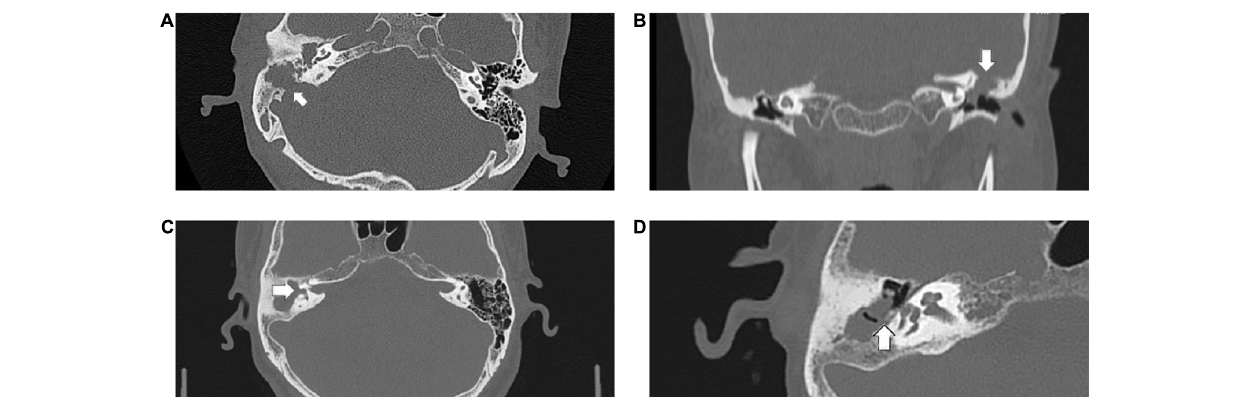
FIGURE 1 | The following CT scan findings were recorded as score 2: (A) the sigmoid sinus bone plate eroded (arrowed), (B) coronal section of the left epitympanum demonstrating a tegmen tympani defect (arrowed), (C) a large defect of the lateral semicircular canal (arrowed), (D) the pyramid segment of facial canal eroded